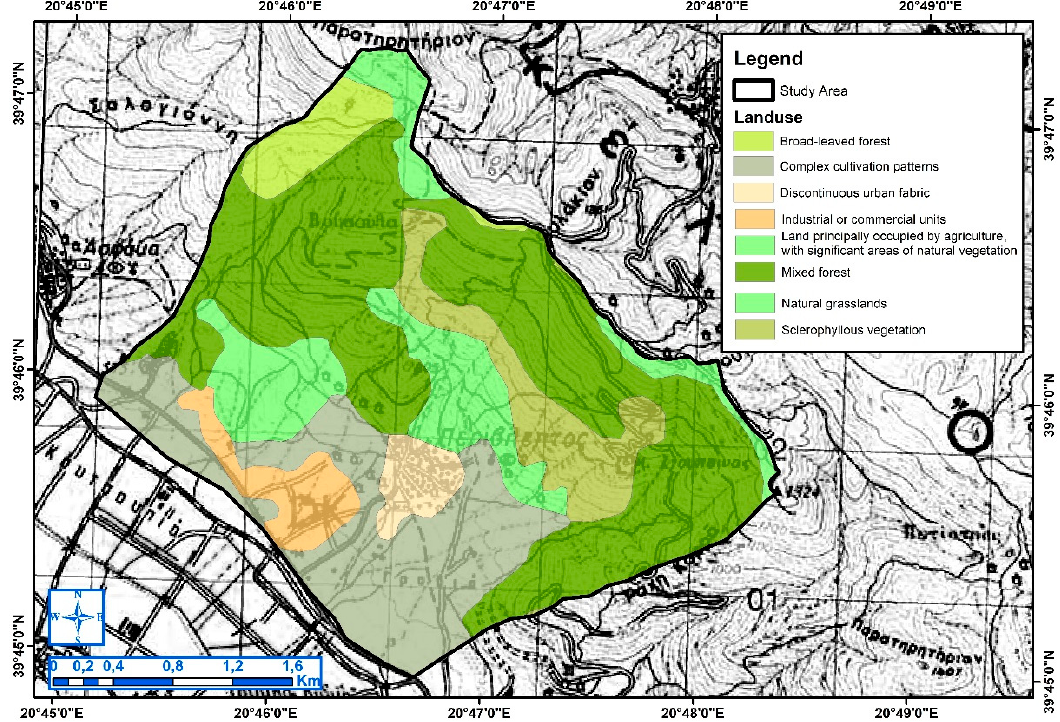
Figure 2. Land use based on Corine Land Cover [41].